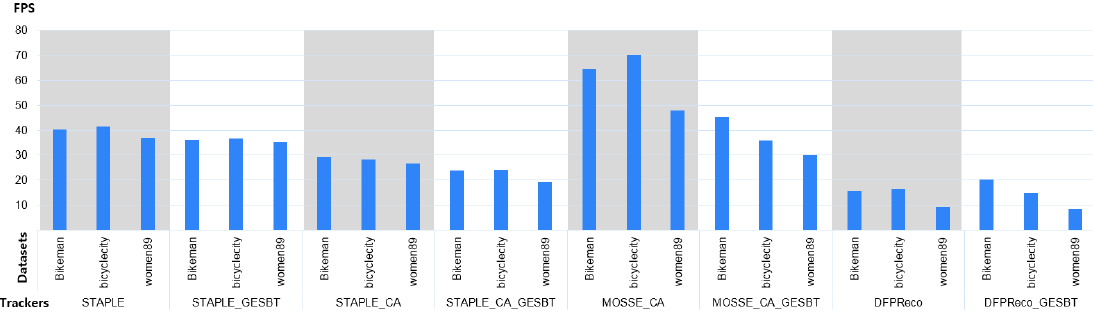
Figure 10. Speed comparison of the baseline trackers and their extensions with the proposed GESBT on three randomly selected sequences from the VOT2019 RGB-TIR dataset. Speed is calculated as frames-per-second (FPS).